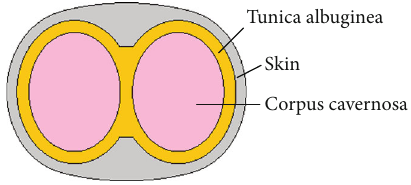
Figure 1: Geometry of the model